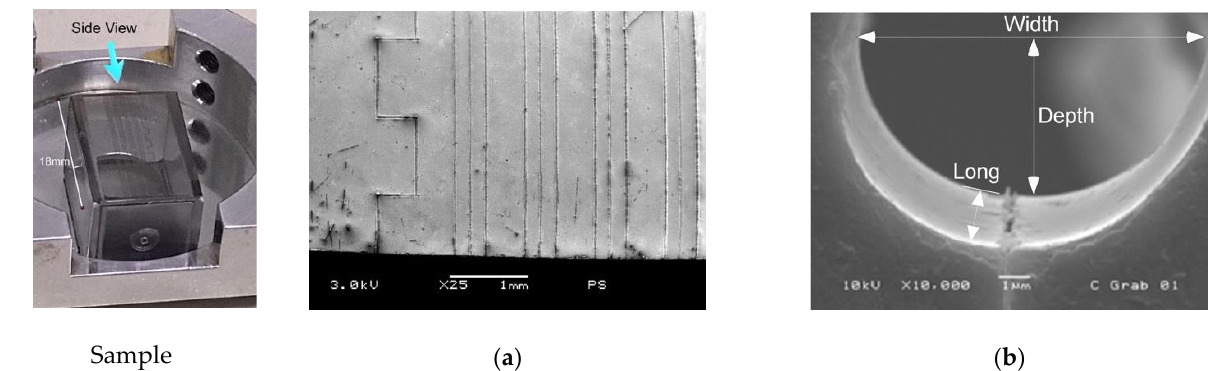
Figure 4. FM sample is obtained onto one side of the polystyrene spectrophotometer cuvette of 10 × 18 mm 2 , using a speed of 0.02 mm s −1 , and average power of 9.3  0.1 mW, focused on a plane coincident with the ablated surface (Z = 0). The ( a ) shows a scanning electron microscope image of a top view of a polystyrene (PS) cuvette for conventional spectroscopic use. ( b ) Scanning cross-section image of an 18 mm long microchannel.